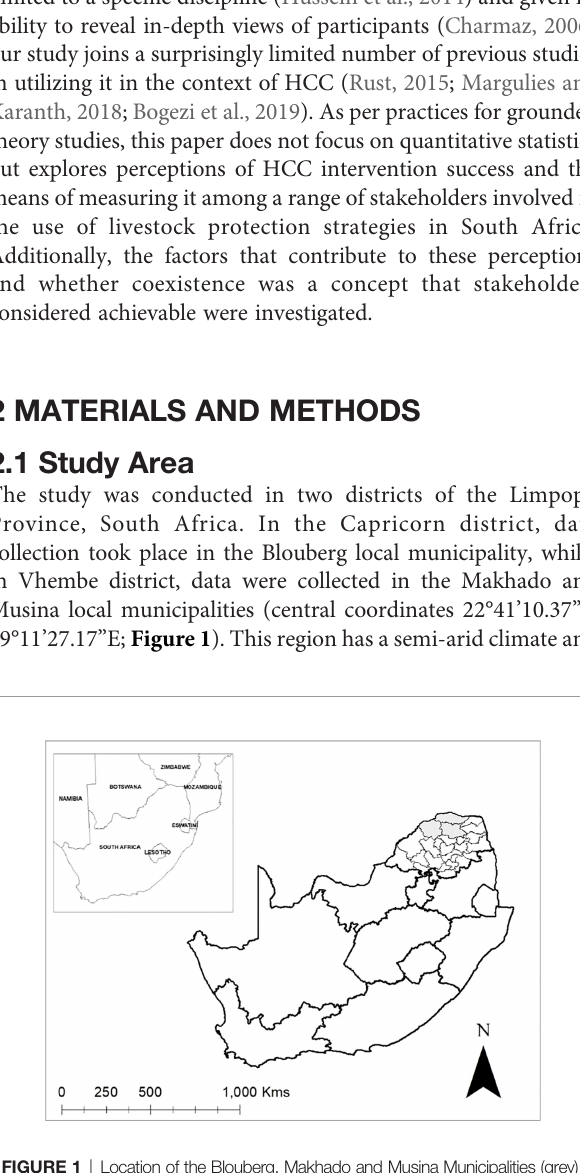
FIGURE 1 | Location of the Blouberg, Makhado and Musina Municipalities (grey) within the Limpopo Province, South Africa, where the data collection occurred. Inset map shows the location of South Africa within Southern